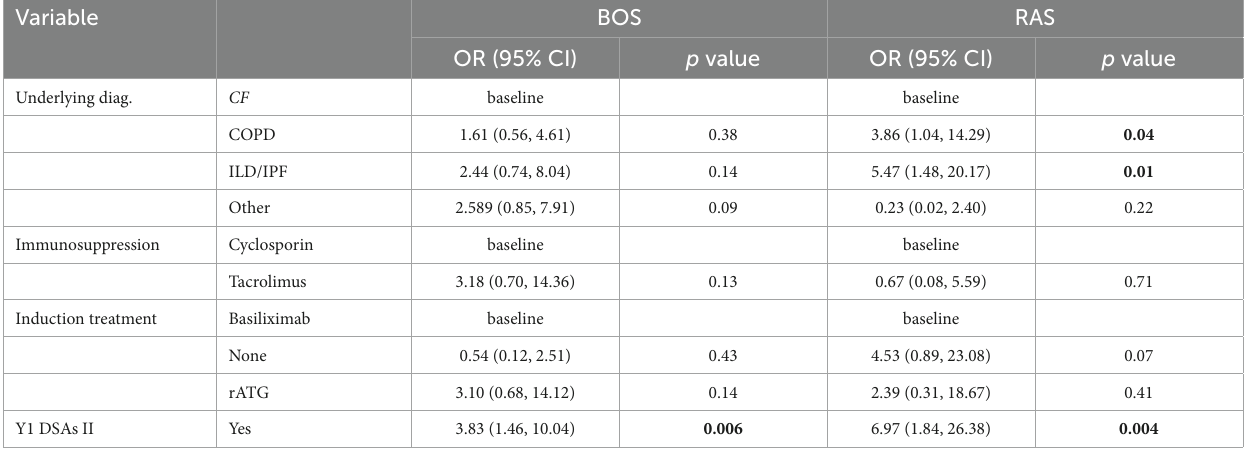
TABLE 1 Risk factors for BOS and RAS by 3 years post-LT as compared to stable recipients by multivariate multinomial analysis, adapted from (23). Variable